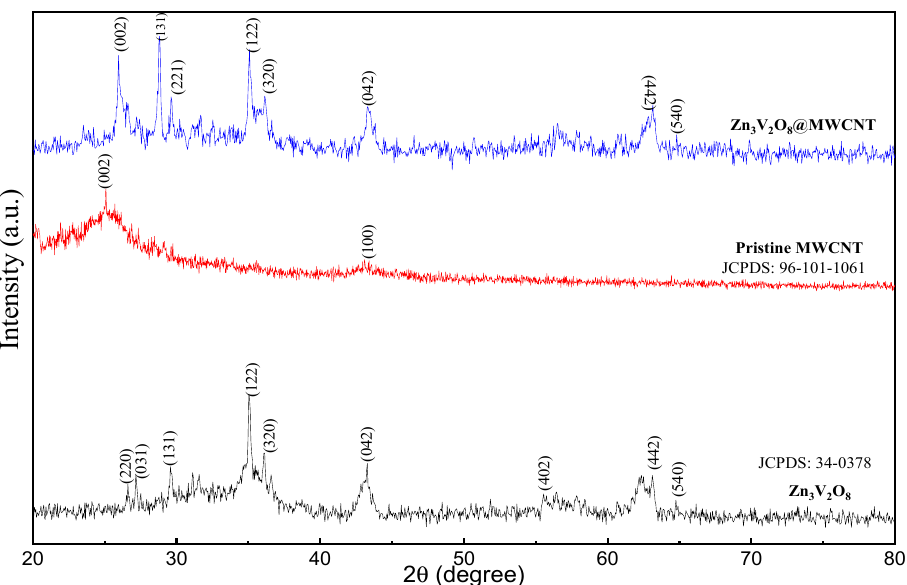
successfully functionalized by MWCNT to form a heterojunction ZV@MWCNT. Since the